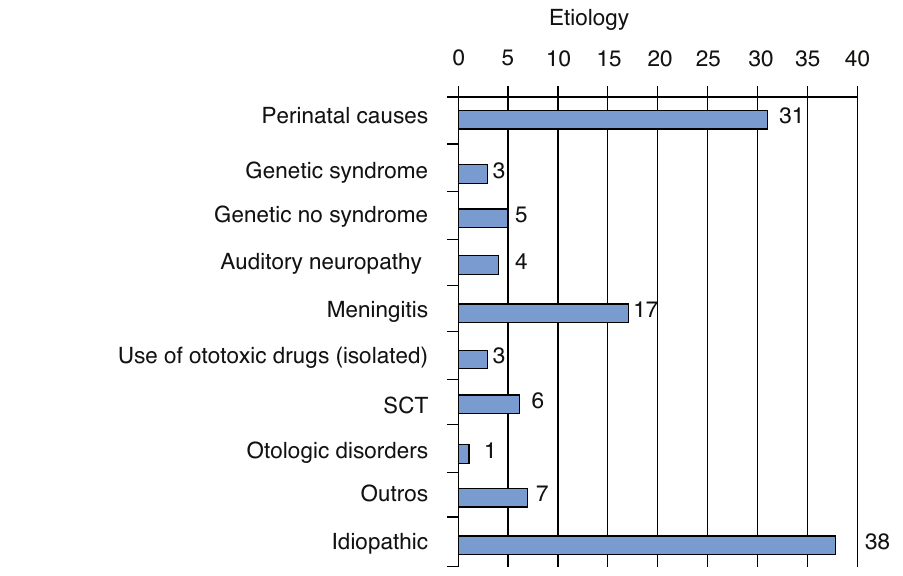
Figure 5 Distribution of patients evaluated in the cochlear implant outpatient clinic according to hearing loss